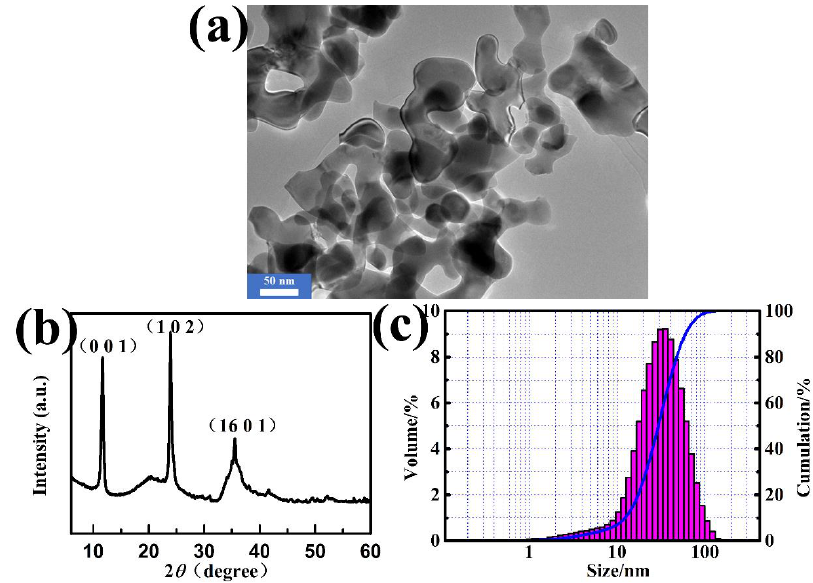
Figure 1. TEM micrograph ( a ), XRD spectrum ( b ), and particle size distribution of milled serpentine powders ( c ). Table 1. X-ray fluorescence analysis results of the milled serpentine particle.